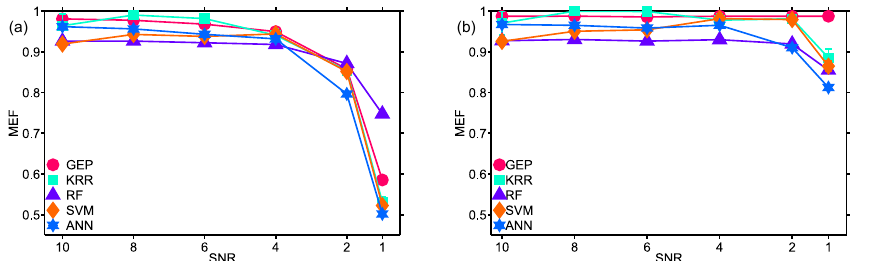
Figure 4. Effect of adding noise to the original signal on the prediction capacity for GEP, KRR, RF, SVM and ANN. The first panel contains the evolution of mean modelling efficiency (MEF) values from 20 independent runs for each increasing level of noise. MEF is computed after learning from a data set of 200 data points and validating against 1000 data points containing noise. The second panel shows the evolution of mean MEF values from 20 independent runs for each increasing level of noise where MEF is computed after learning from a data set of 200 data points and validating against noise-free 1000 data points generated from Eq.